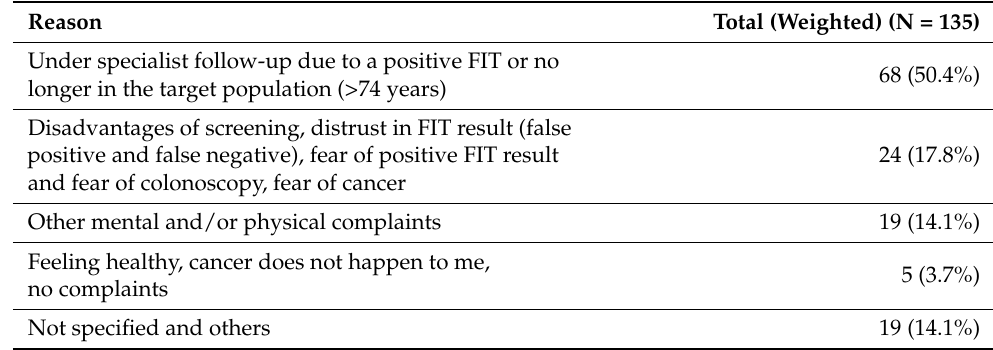
Table 3. Reasons for no future FIT participation